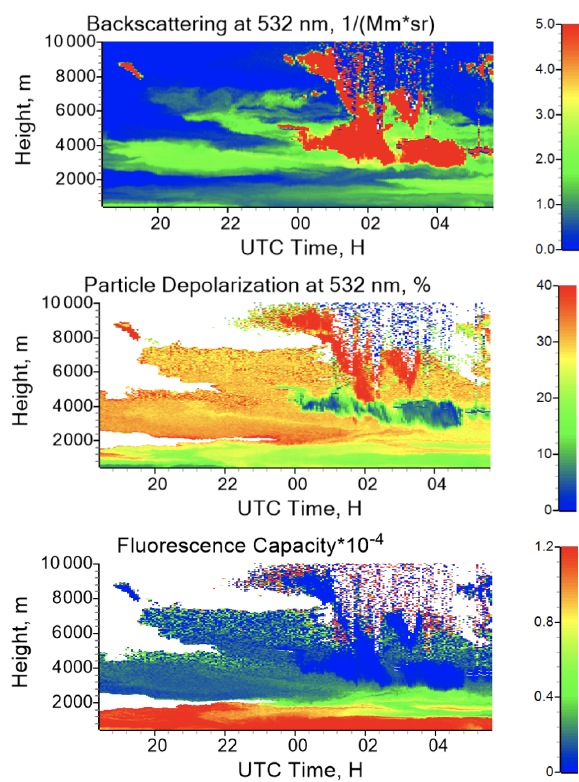
Figure 2. Spatiotemporal distributions of the backscattering coef- ficient β 532 , the particle depolarization ratio δ 532 , and the fluores- cence capacity G F on the night of 2–3 March 2021. The backscatter- ing coefficient β 532 is calculated with the modified Raman method. The values of δ 532 and G F are shown for β 532 > 0.2Mm − 1 sr − 1